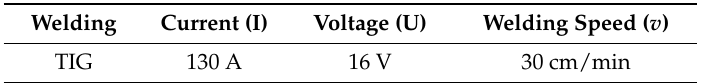
Figure 1. Welding and measuring setup. ( a ) Dimension of plate ( b ) Measuring system. Table 1. Welding parameters.